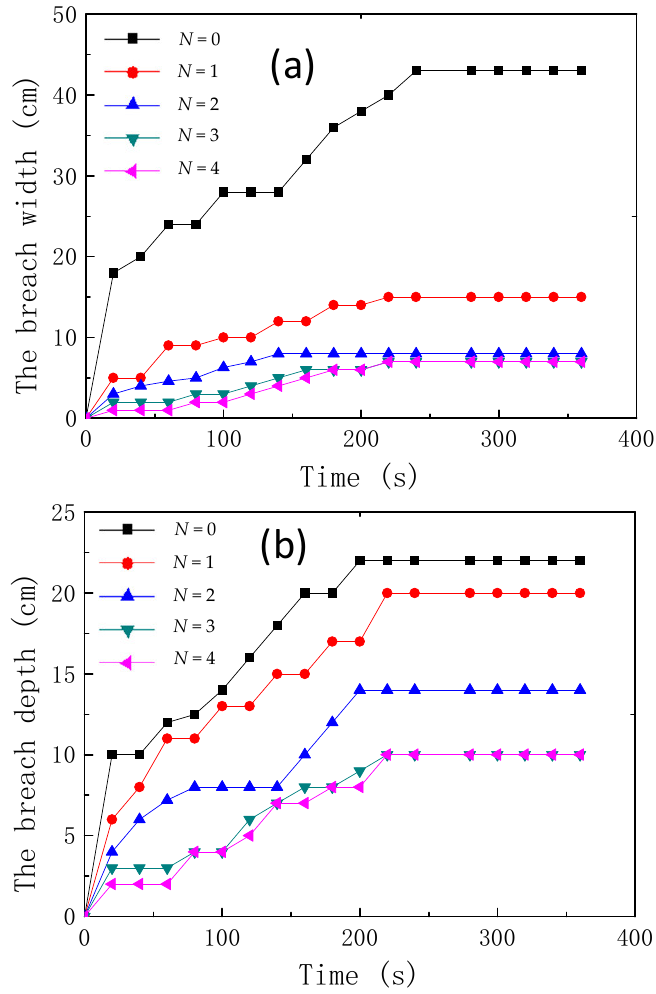
Figure 11. The width/depth changes graph of breach, ( a ) breach width; ( b ) breach depth.